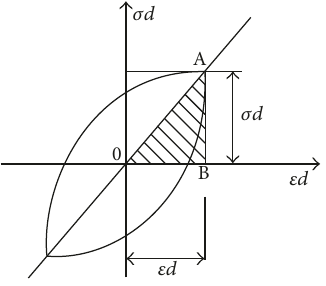
Figure 11: Curve showing the stress hysteresis loop of frozen soil.